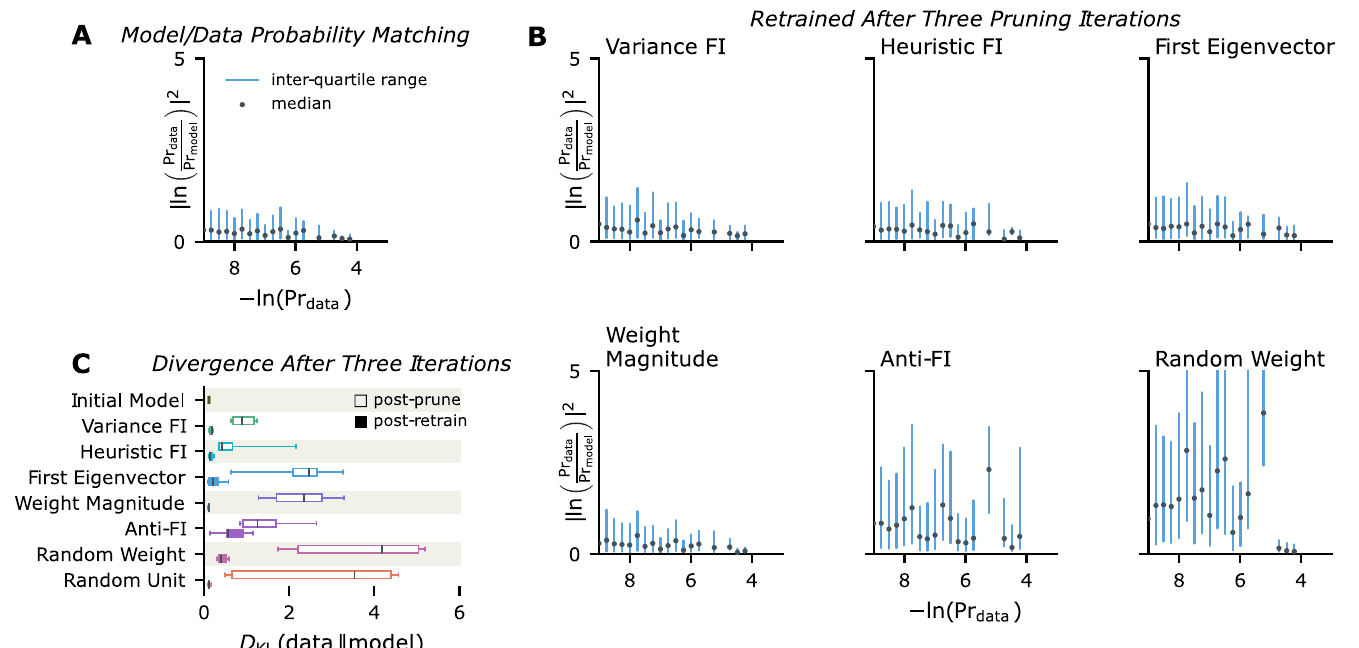
Fig 2. Generative performance of networks before and after iterative pruning. Half of the weights were removed in each of 3 pruning iterations; all plots reflect 10 independent simulations. (A) Mean-Squared-Error (MSE; vertical axis) between the log-probability of a pattern in the training data (horizontal axis) and the log- probability of the corresponding pattern generated by the trained model. Black points reflect the average MSE over 10 realizations; Blue lines indicate the 25 th -75 th percentile range. (B) Log-probability matching after three iterations of synaptic pruning (according to different criteria) and retraining. Accuracy remains good for pruning rules based on weight magnitude and Fisher information. (C) Kullback-Leibler divergence between the distribution over training instances vs. the distribution over generated samples, after three iterations of pruning before and after-retraining. Retraining generally restores generative performance.